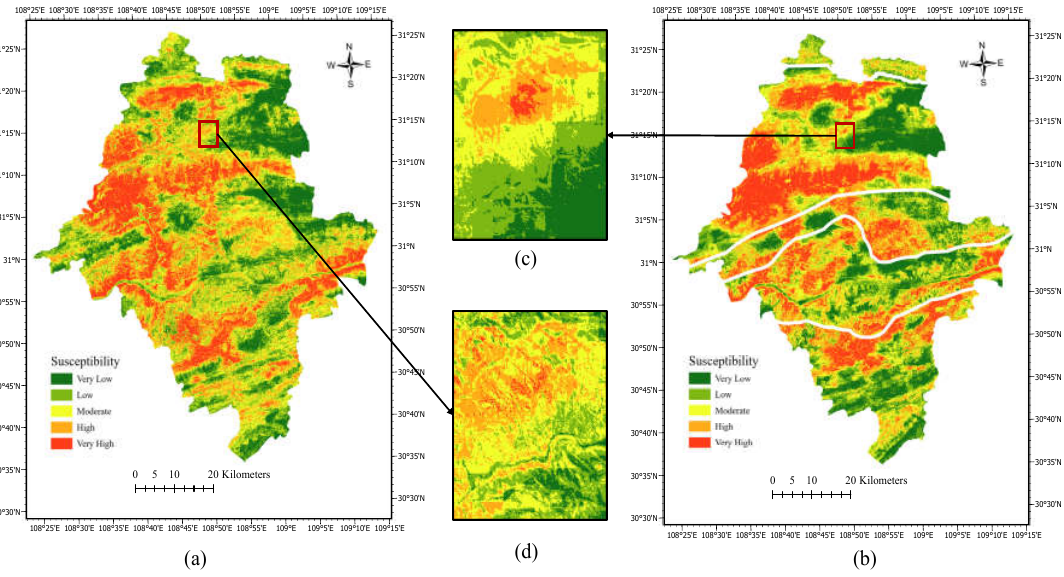
high) by the method of natural breaks method. From the result of the parent model in Table 5, 14.6% of the whole area is classified as a very low landslide-prone zone, 22.8% as a low landslide-prone zone, 25.23% as a moderate landslide-prone zone, 21.47% as a high landslide-prone zone, and 15.90% as a very high landslide-prone zone. From the result of the sub-models, their ratios are 16.42%, 20.81%, 22.56%, 21.54%, and 18.67%, respectively.